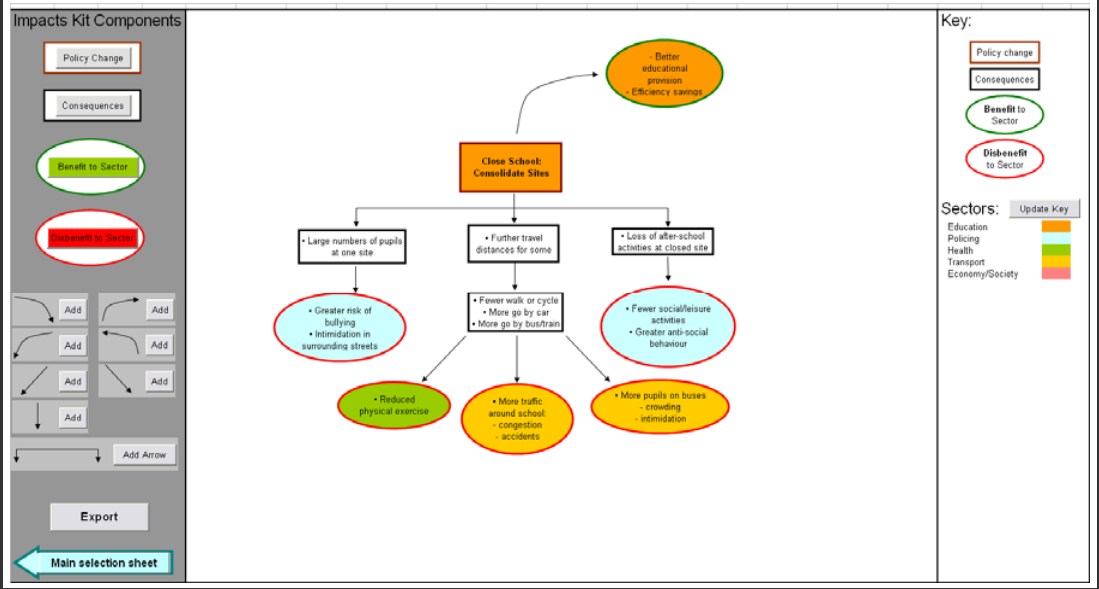
Figure 7. Assessing the strategy level impact of a policy change Source: Jones and Paskins (2008b), Figure